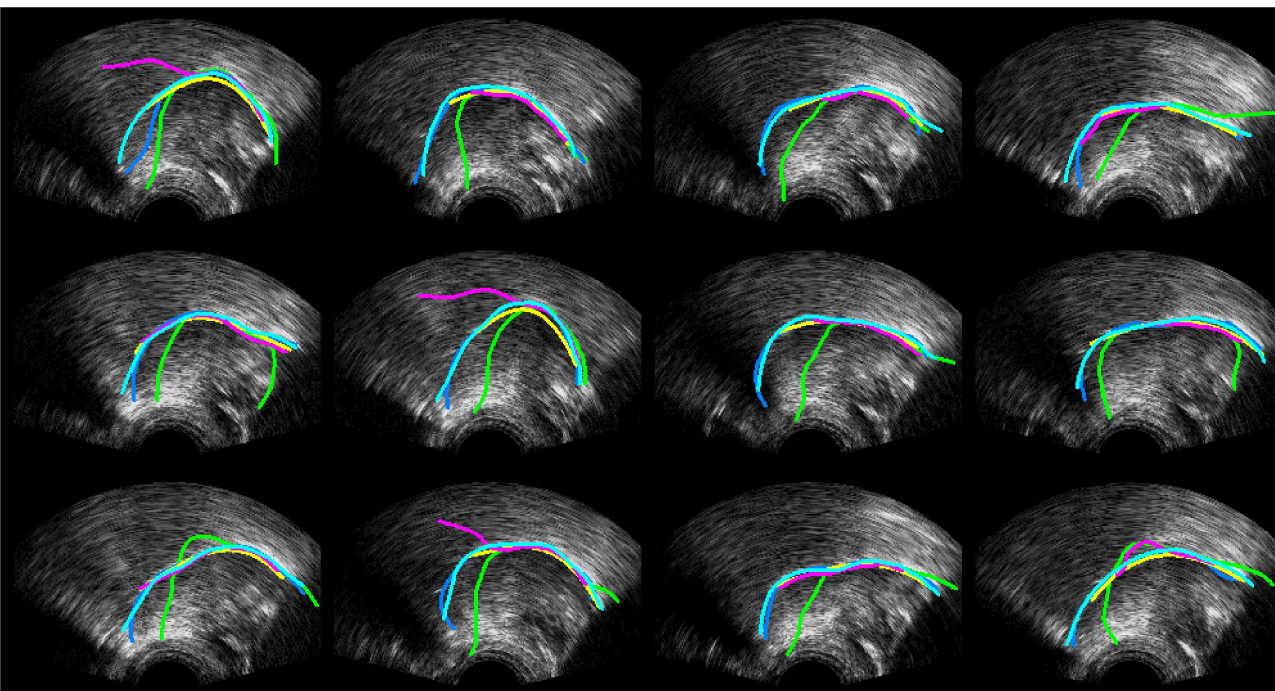
Figure 12. Speaker UltraSpeechDF; blue—hand-label; green—SLURP; yellow—MTracker; pink— DeepEdge; Cyan—DLC_ResNet50.